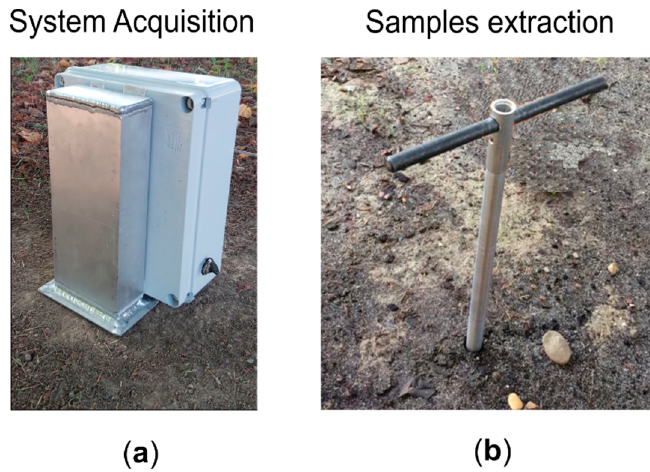
Figure 6. ( a ) System acquisition and ( b ) samples extraction on real soil.